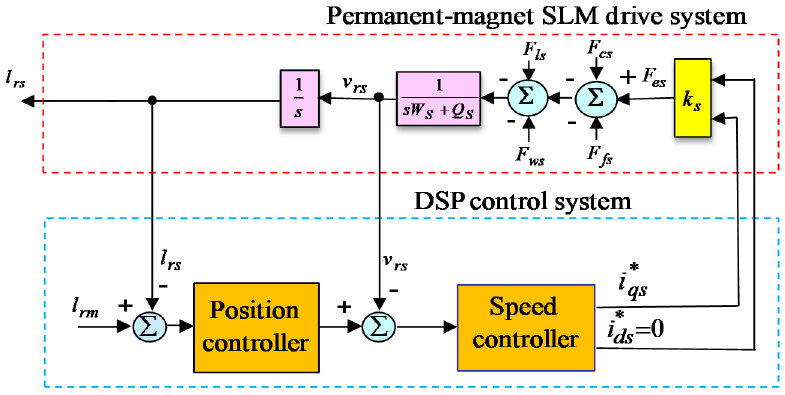
Figure 2. Block diagram of understood control system.